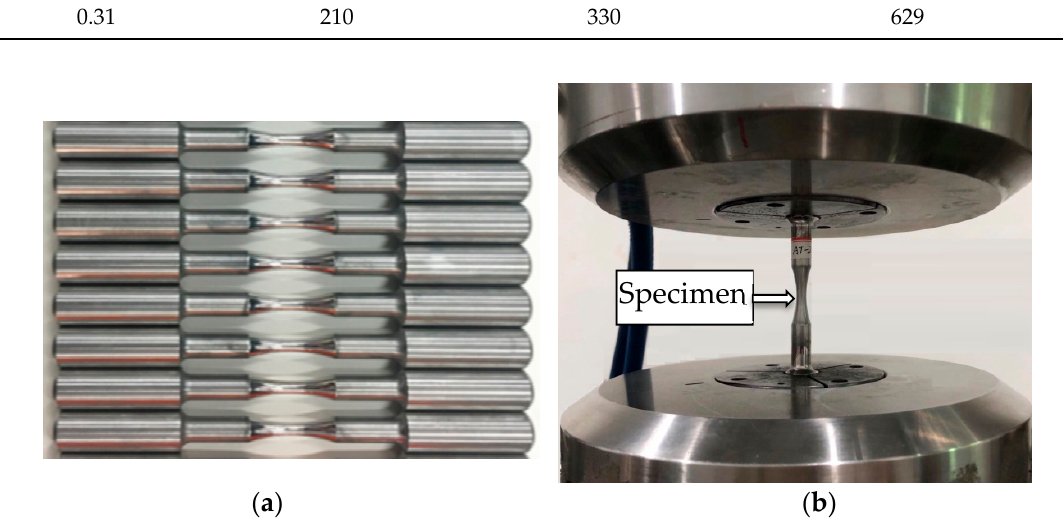
Figure 1. ( a ) Specimens and ( b ) a specimen clamped on the test machine. Table 1. The material properties of LZ50 steel.